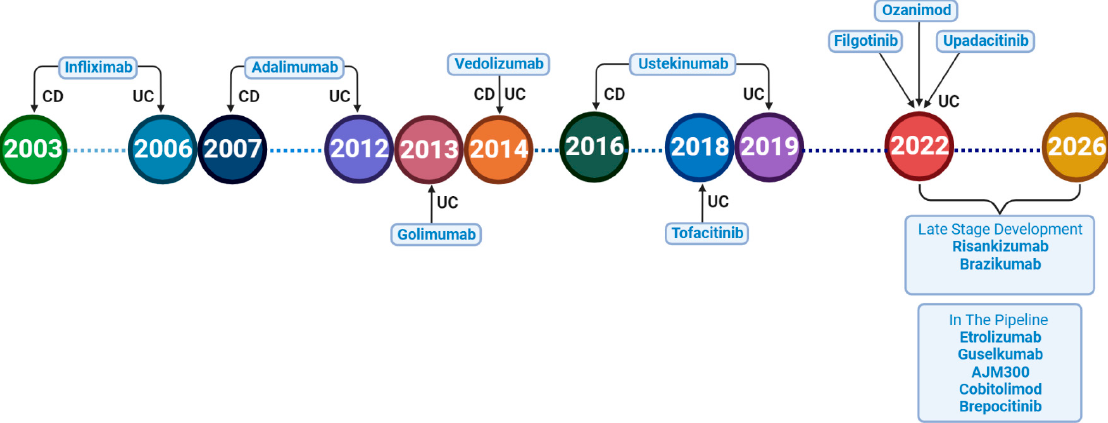
Figure 2. Timeline for the different biologics and small molecules approved by the FDA and in the development process for the treatment of IBD.